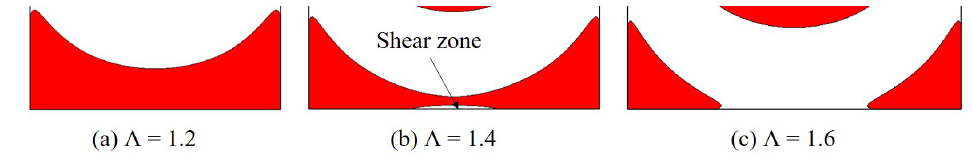
Figure 14. Transformation in the dead zone with various cavity widths at Od = 5 .